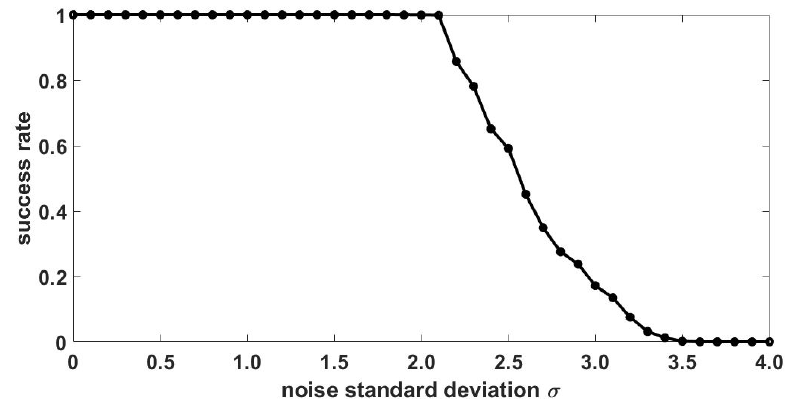
Figure 7. Success rate according to noise standard deviation (using 10 power